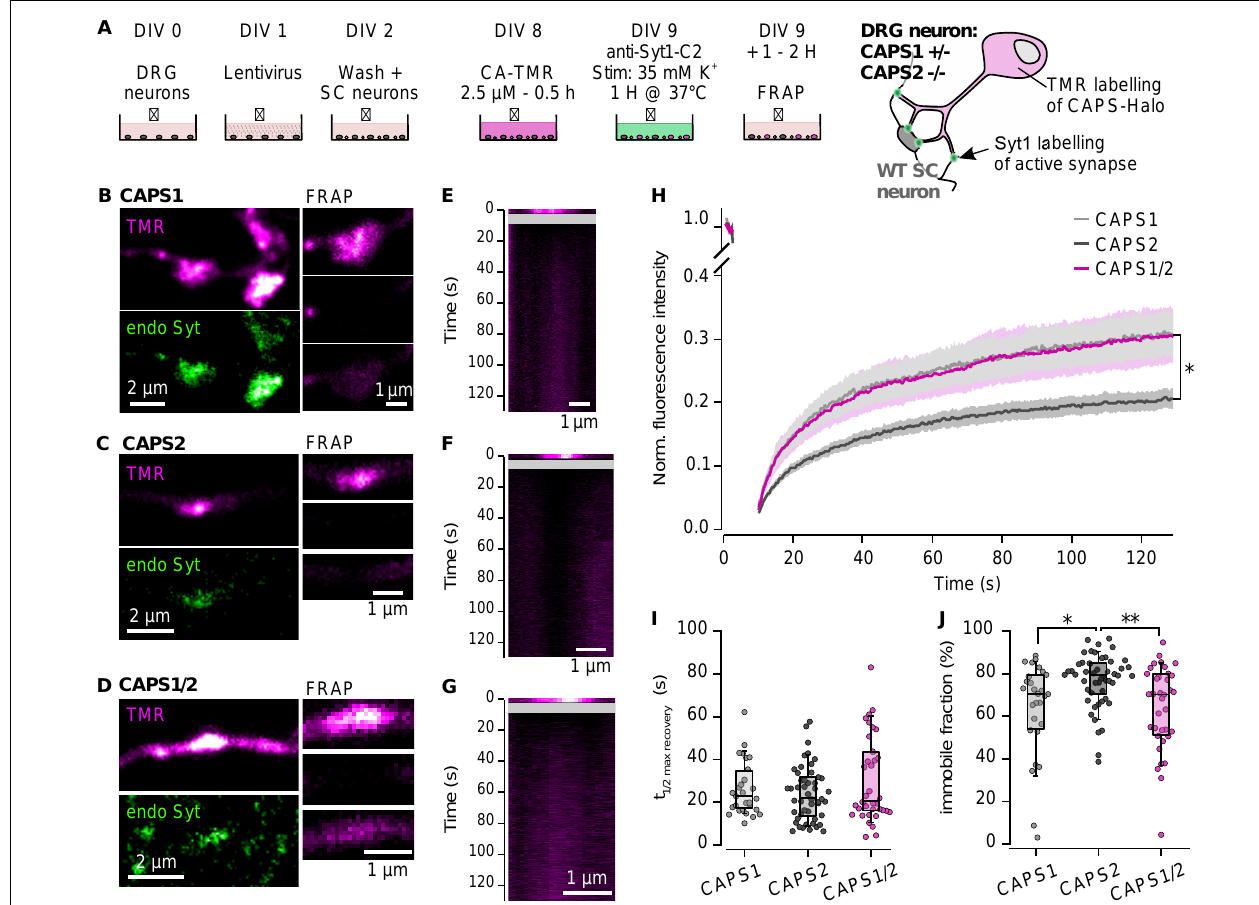
FIGURE 7 | N-terminal sequence of CAPS1 induces its specific transport in synapses. (A) Schematic representation of the staining protocol (left). DRG neurons were isolated from CAPS1 + / − CAPS2 − / − mice and co-cultured with WT SC neurons and transfected with lentiviruses encoding for the respective CAPS construct on DIV1. Vital staining of the cells with bleachable HaloTag ligand CA-TMR (magenta) was conducted on DIV8. On DIV9 the neurons were incubated for 1 h in weak depolarizing conditions (35 mM K + ) with an antibody directed against the luminal domain of synaptotagmin1 coupled to Sulfo-Cyanine 2 (Syt1-C2). This antibody is taken up by endocytosis in active synapses that are then labeled in green. The neurons were allowed to recover for 1 h at 37 ◦ C before proceeding with the FRAP experiment. The result of the staining protocol is schematically shown on the right. (B–D) Left are shown the labeling of the synapse with HaloTag ligand CA-TMR (magenta) and with Syt1-C2 (green). On the right are shown 3 snapshots of the selected synapse just prior to photo-bleaching (top), just after (center) and 120 s (bottom) after photo-bleaching. Representative synapses for neurons transfected with CAPS1-, CAPS2b- and CAPS1/2-Halo are displayed in (B–D) , respectively. (E–G) Kymogram representation of the FRAP recording shown in (B–D) , respectively. The line scan was made through the synapse parallel to the neurite. (H) Average fluorescence recovery over time of synapses in DRG neurons expressing CAPS1- (light gray), CAPS2b- (dark gray) and CAPS1/2-Halo (magenta). * p = 0.047 and 0.022 for CAPS1 and CAPS1/2 vs. CAPS2, respectively. (I) Half time recovery of maximal fluorescence represented as box plot super imposed with the values of individual cells. (J) Immobile CAPS fraction displayed as box plot super imposed with the values of individual cells. * p = 0.018 and ** p = 0.005 for CAPS1 and CAPS1/2 vs. CAPS2, respectively. Number of measured synapses from either native CAPS dKO neurons or expressing either CAPS1, CAPS2b, or CAPS1/2 chimera was 28, 50, and 36 respectively, in three independent experiments.